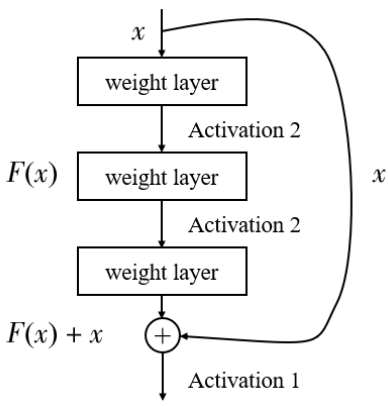
Figure 9. Residual block of mixed activation functions. Table 5. Training results of twenty ResNet50 network architectures improved by mixed activation functions.